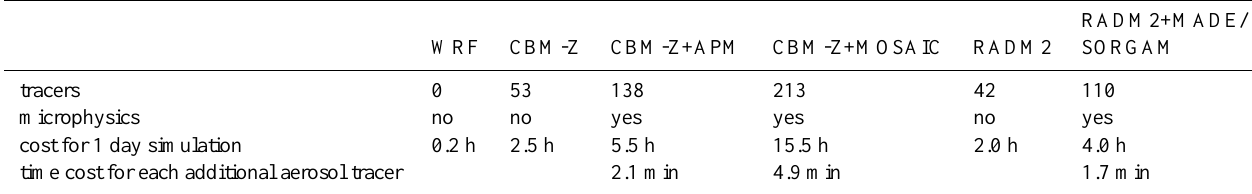
Table 1. The comparison of computational costs among different chemistry and aersol schemes in WRF-Chem.